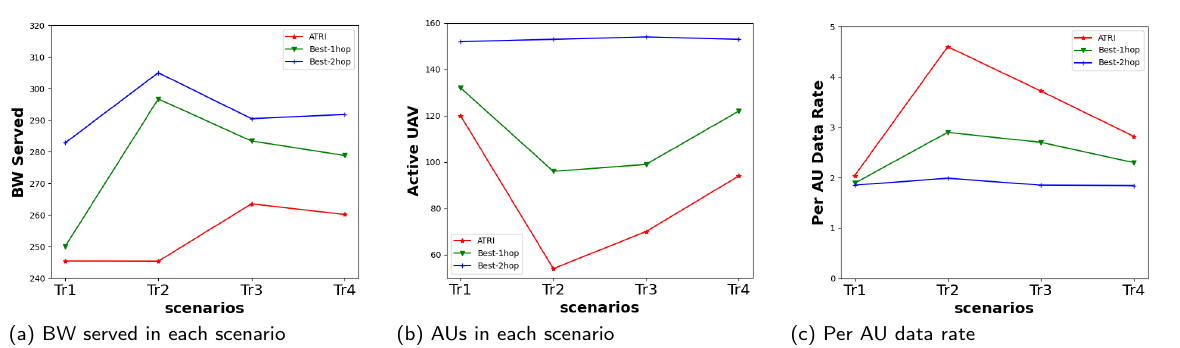
Figure 7. Comparing the best fitness obtained using GANet 1-hop, GANet 2-hop, and ATRI.